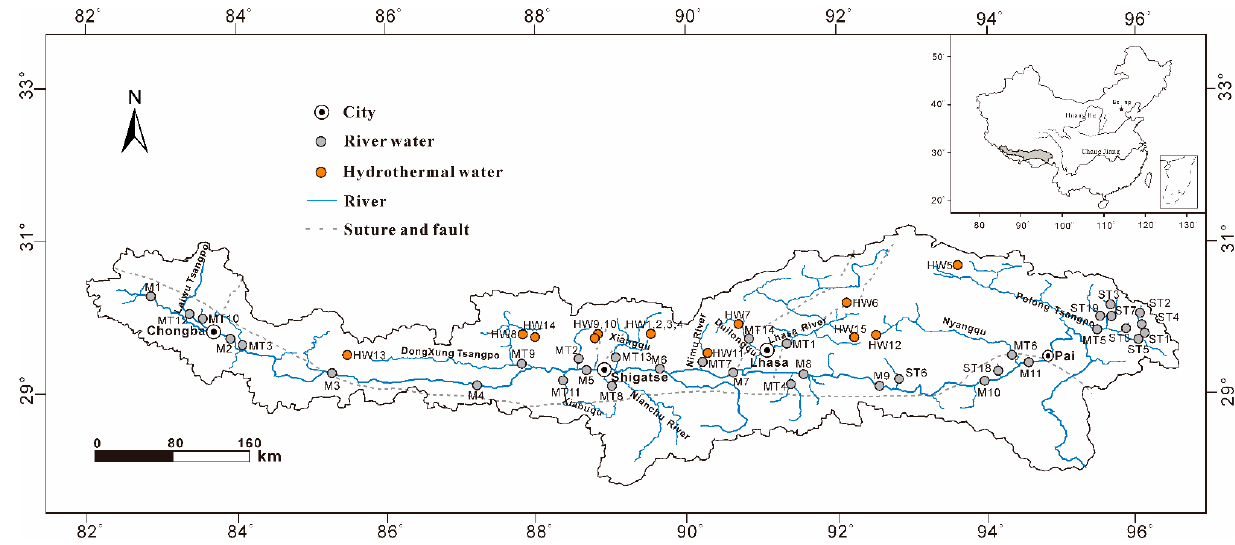
Figure 1. Sketch map of the study area and sampling sites.